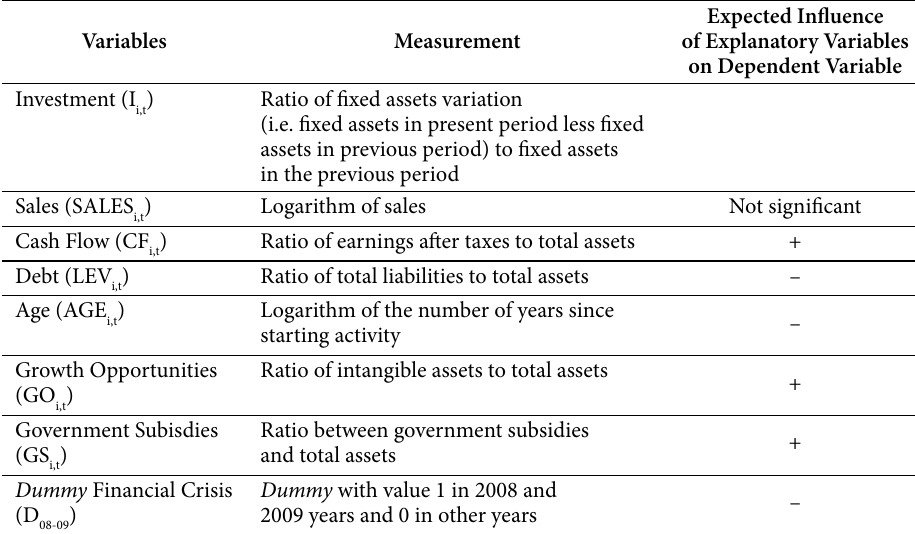
Table 2. variables and measurement